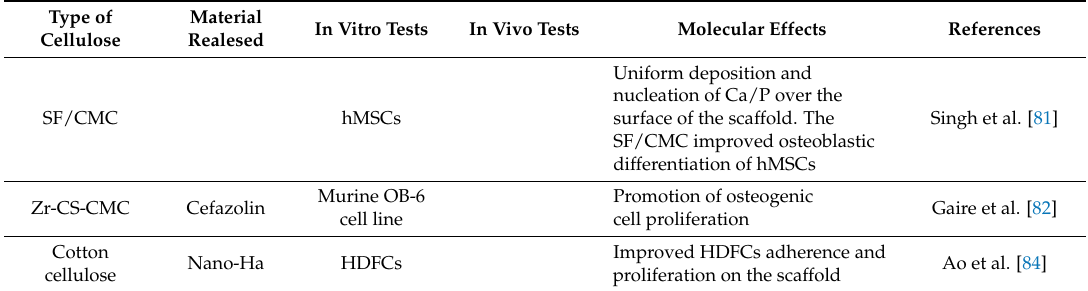
Table 3. Summary of the nano cellulose-based materials tested in bone